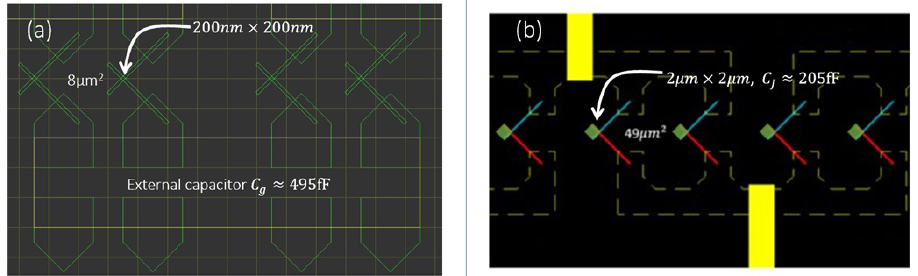
Figure A1. Various designs of SQUIDs. ( a ) Each SQUID unit cell was shunted by a large C g ≈ 0 . 5pF the ground. The common ground electrode is shown by a yellow rectangle. ( b ) SQUIDs formed by large JJs with junction area A JJ ≈ 2 . 2 ¯m 2 . Yellow rectangles show electrodes used to measure the IVC of individual SQUIDs.